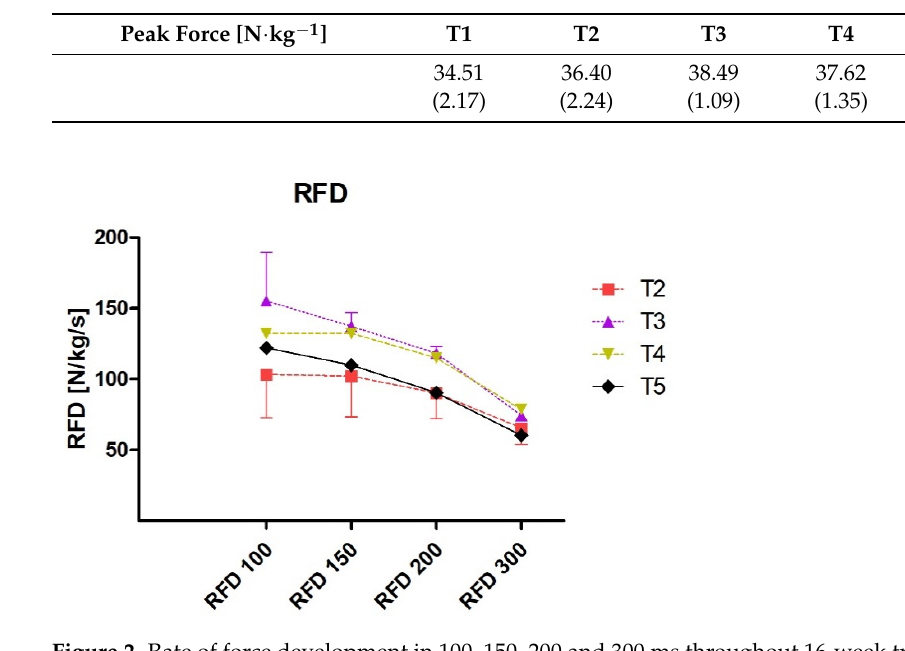
Figure 2. Rate of force development in 100, 150, 200 and 300 ms throughout 16-week training.